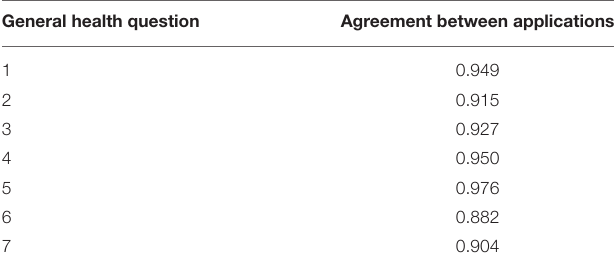
TABLE 1 | Kappa value for each general health question between two applications of the Brazilian version of the PAR-Q + . General health